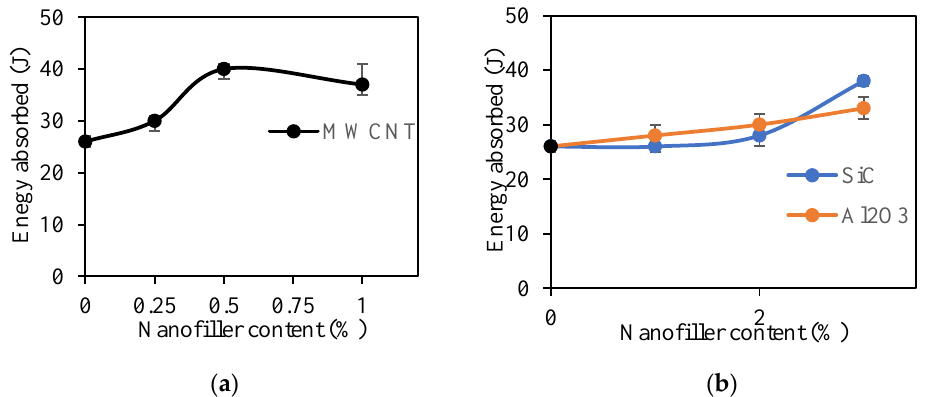
Figure 11. Impact test of nanofiller incorporated Kevlar / epoxy composites: ( a ) MWCNT, ( b ) SiC, and Al 2 O 3 .